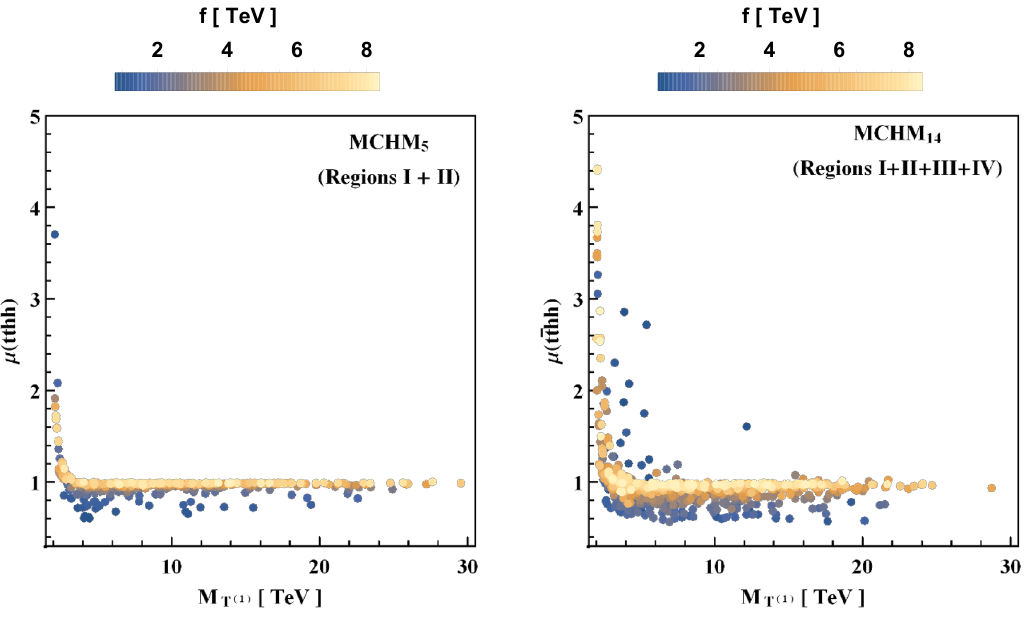
Figure 17 . Normalized tthh cross section as a function of the lightest Q = 2 / 3 resonance mass at √ s = 100 TeV. The value of the global scale of symmetry breaking is also color coded. These points are obtained by joining all the regions in each